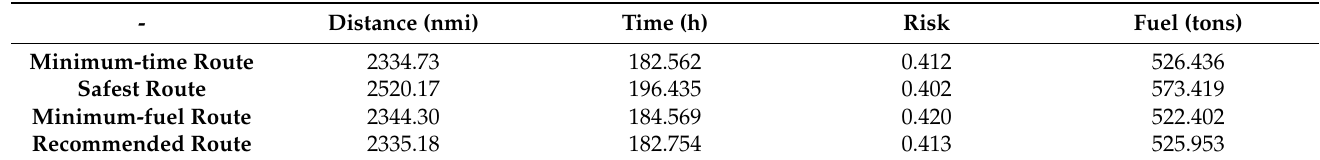
Table 7. Objective function values of five routes in complex offshore